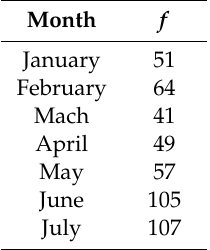
Table 1. Number of posts per month